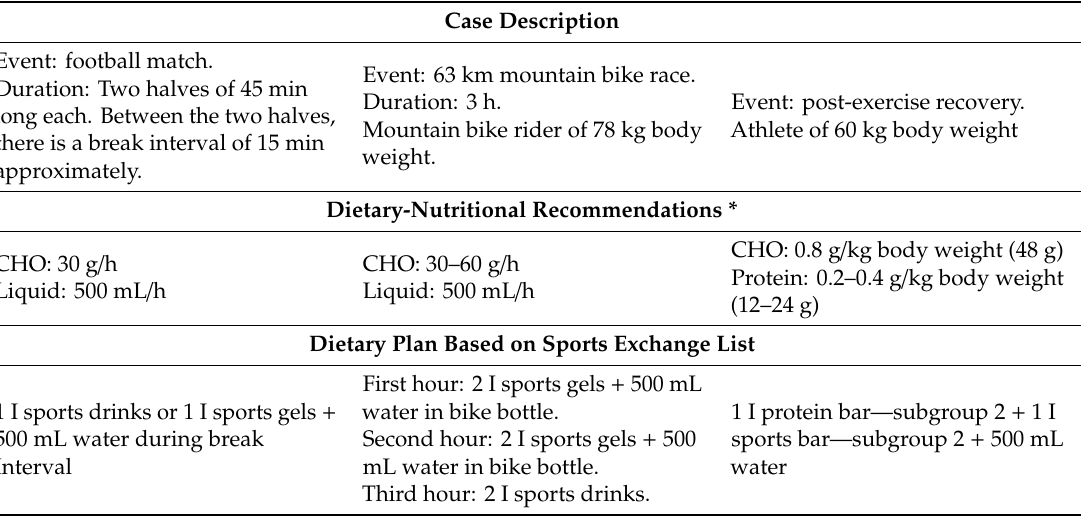
Table 6. Examples of dietary plans through sports foods exchange list. Case